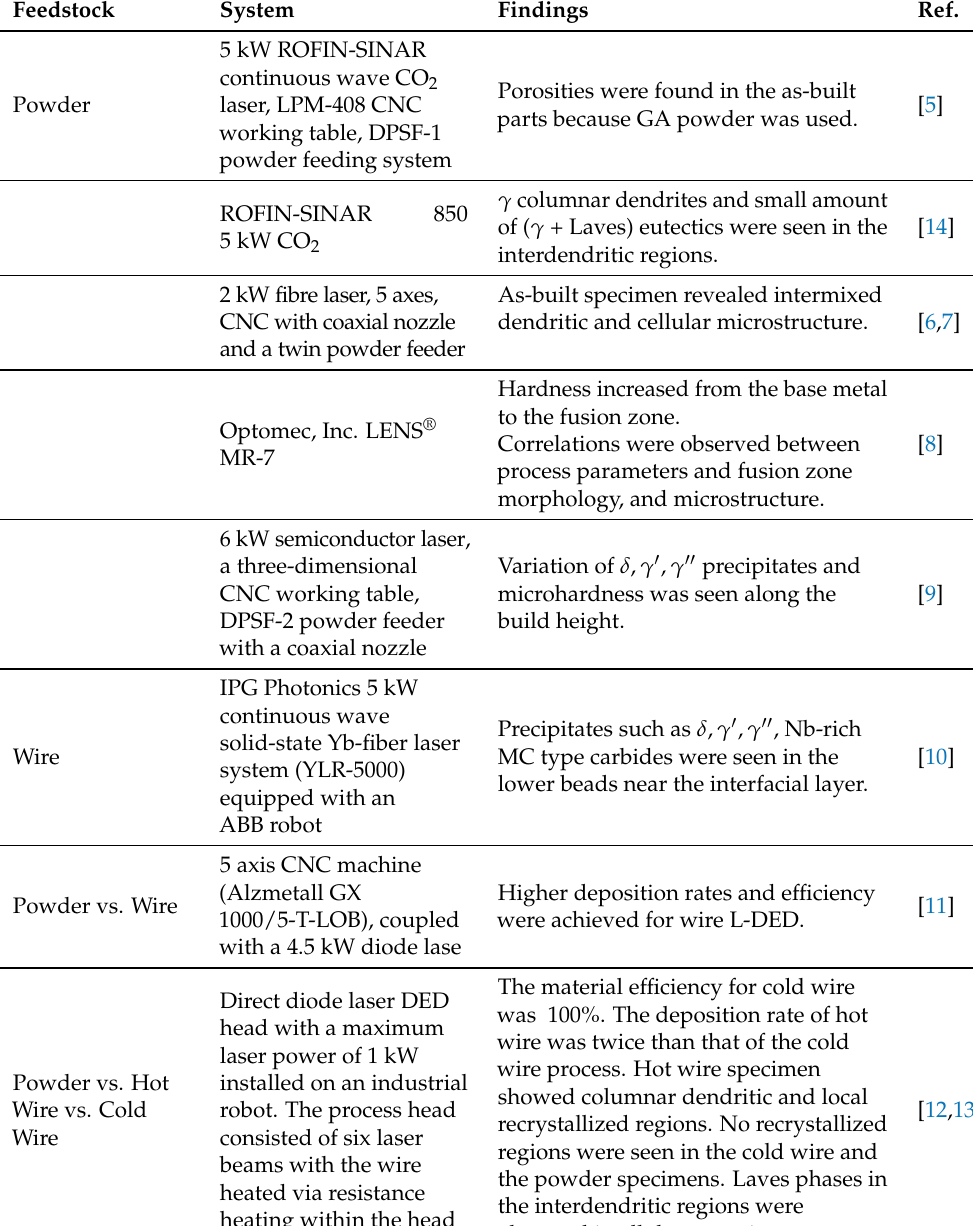
Table 1. Summary of powder- and wire-fed L-DED for fabricating IN718 specimens. Feedstock